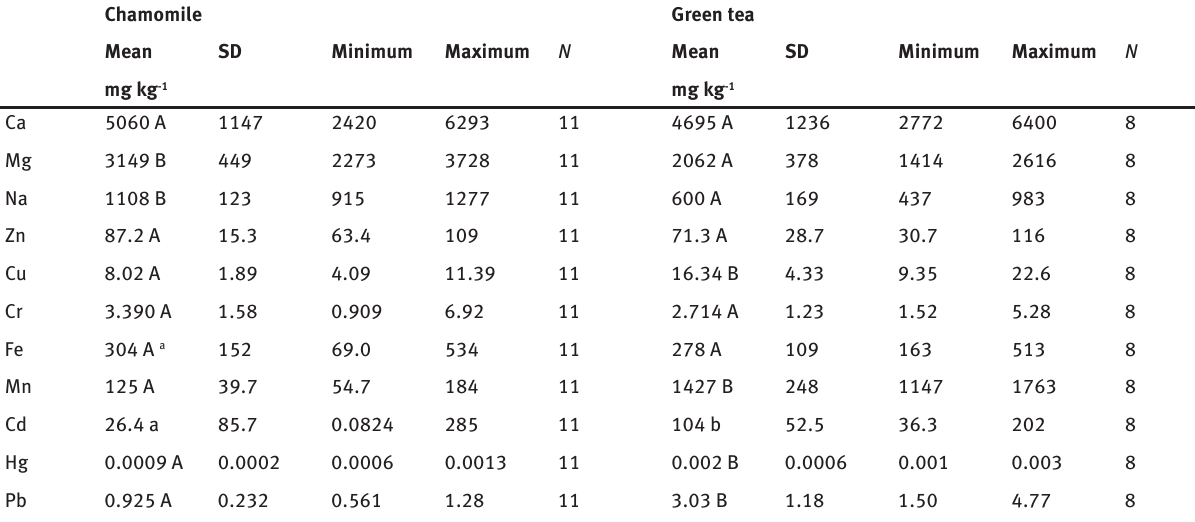
Table 6: Descriptive statistics of metal content in chamomile and green teas leaves. Chamomile